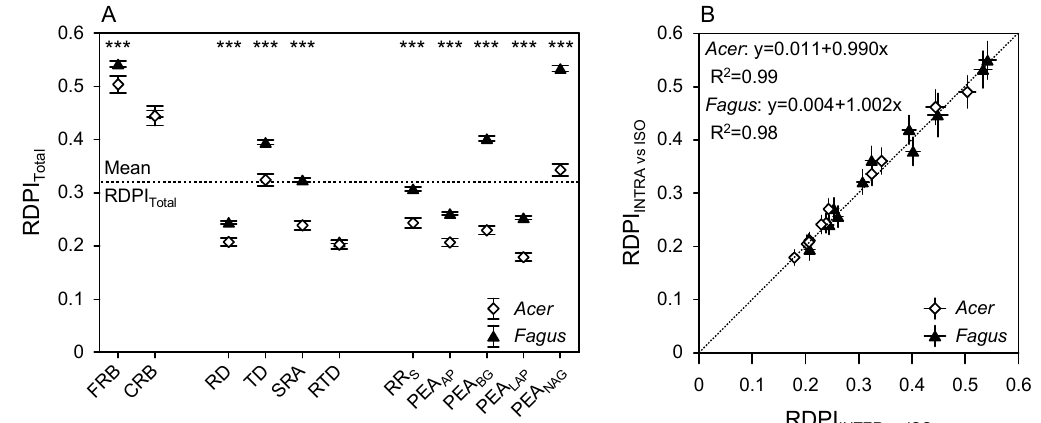
Figure 2. ( A ) Biomass (g DM, dry matter) of fine roots of Acer pseudoplatanus (A) and Fagus sylvatica (F) grown under three di ff erent competition treatments each into nutrient-rich soil patches. A, Acer root grown in isolation (no competition); A:A, Acer root grown in competition with another Acer root; A:F, Acer grown in competition with Fagus ; F, Fagus grown in isolation; F:F, Fagus grown in competition with Fagus ; F:A, Fagus grown in competition with Acer. Significant di ff erences between treatments are indicated by di ff erent letters ( t -test, p < 0.05; mean + standard error (SE), n = 39–52; see Supplementary Table S2 for GLM statistics on log-transformed FRB data). ( B ) Relative competition intensity (RCI) based on fine root biomass (FRB) of Acer (open rectangles) and Fagus (filled triangles) under 1) intraspecific competition (INTRA) relative to isolation (ISO), 2) interspecific competition (INTER) relative to ISO, and 3) INTER relative to INTRA. Tendencies between species are indicated by (*) ( t -test, p = 0.06; mean ± SE, n = 39–52). *************** *** *** ******